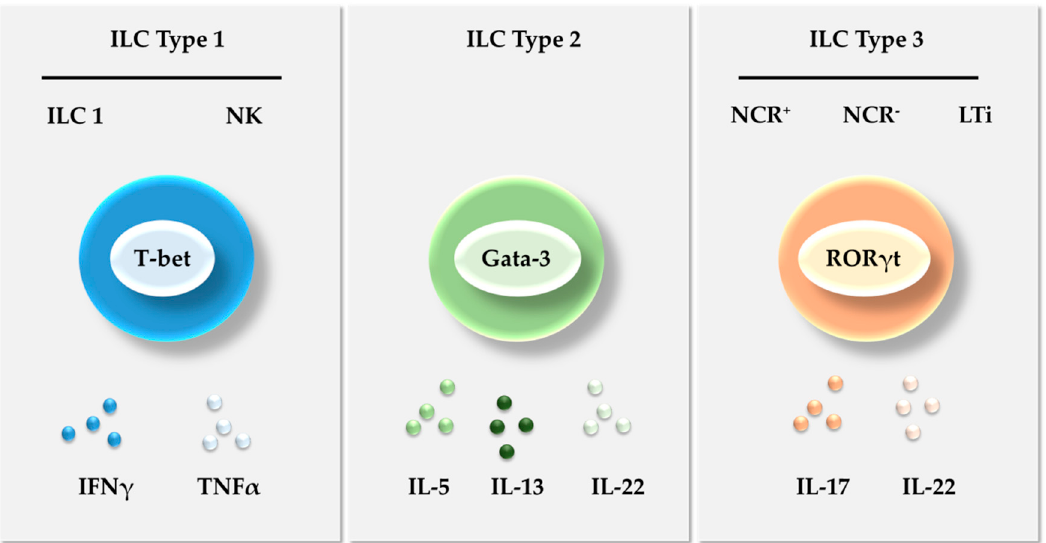
Figure 1. Innate lymphoid cell classification. The ILCs are classified into three main groups—Type 1, Type 2, and Type 3 ILCs—according to the differential expression of transcription factors and specific cytokine repertoires that they produce. NCR—Natural cytotoxicity receptors; IFN γ —Interferon gamma; TNF α —Tumor necrosis factor alpha.